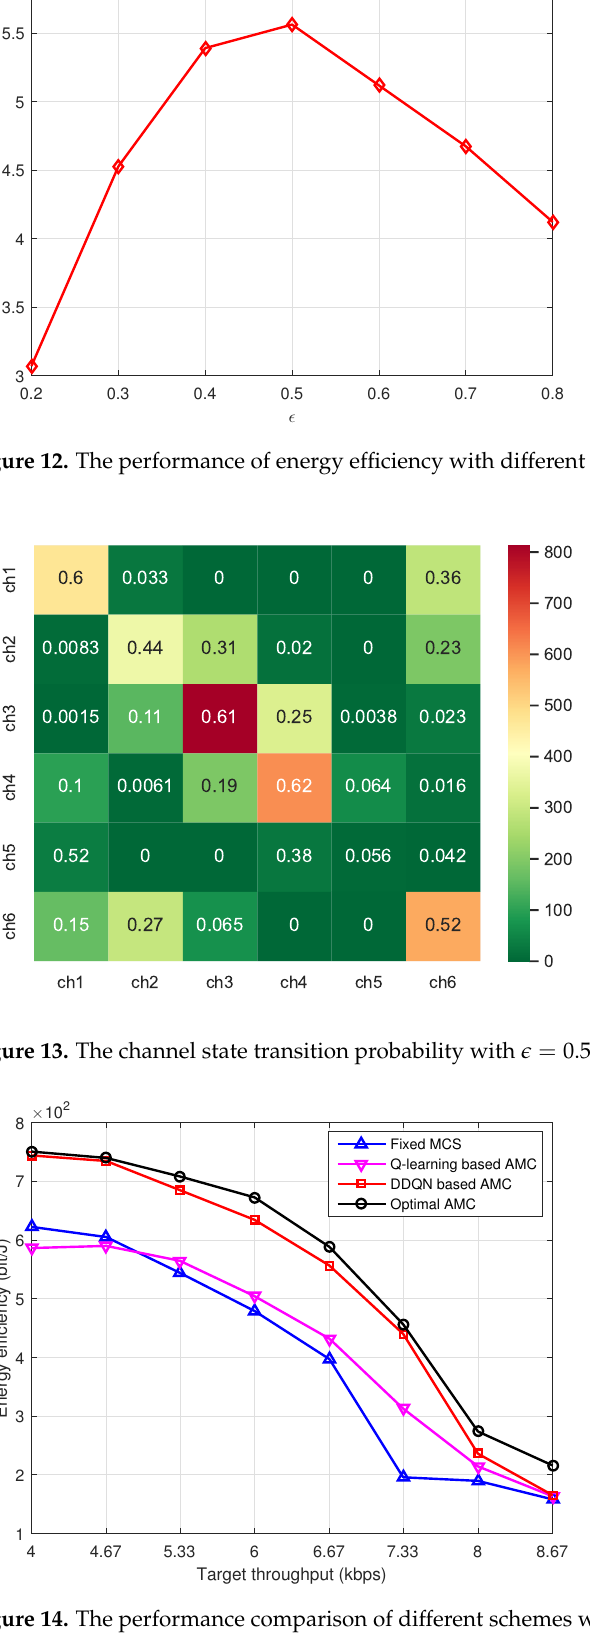
Figure 14. The performance comparison of different schemes with different target